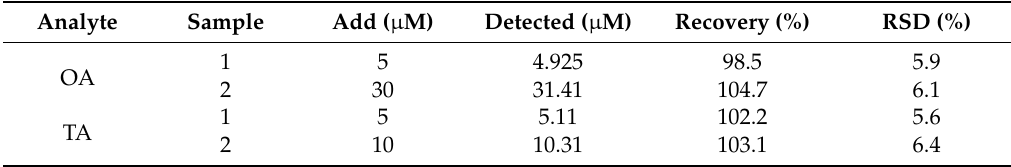
Table 2. Determination of OA and TA in beer samples using ERGO/GCE ( n = 5). Analyte Sample Add ( µ M) Detected ( µ